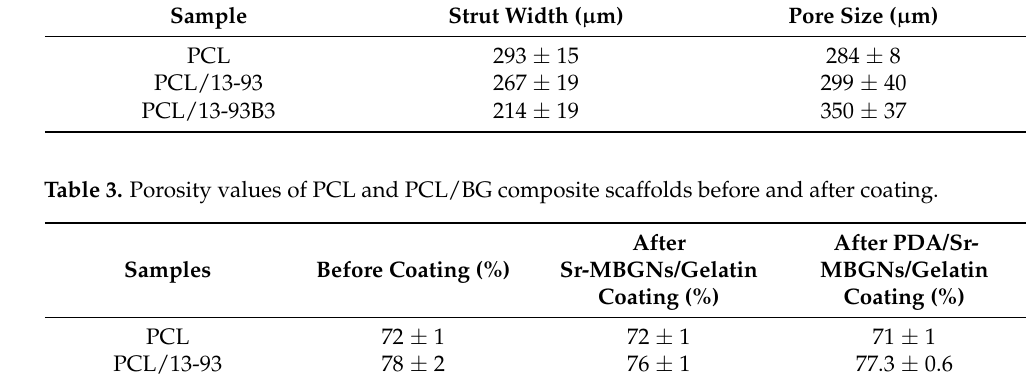
Table 2. Strut width and pore size of uncoated scaffolds (ImageJ). Sample